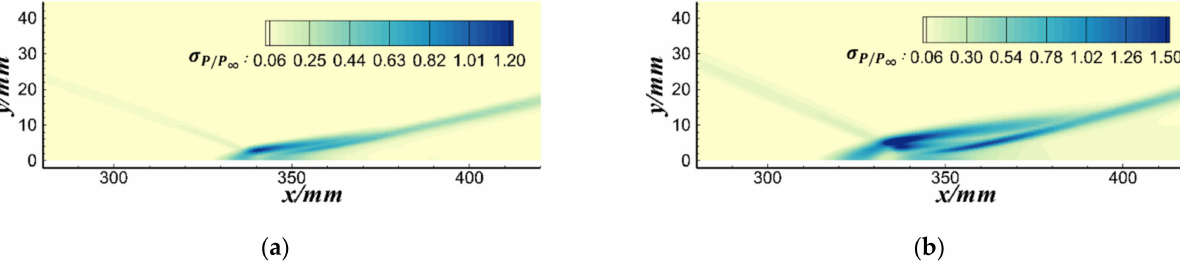
Figure 8. Standard deviation of pressure coefficient contour for the two cases. ( a ) θ = 10 ◦ ; ( b ) θ = 14 ◦